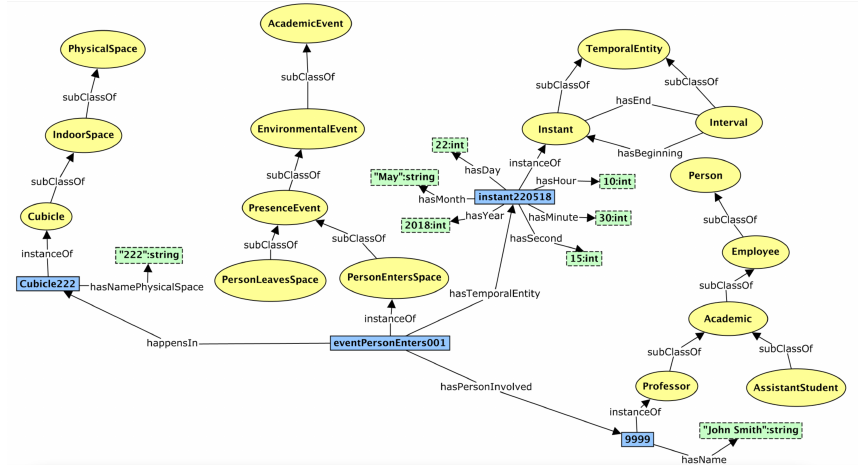
Figure 7. Ontological model instantiated with environmental event (scenario